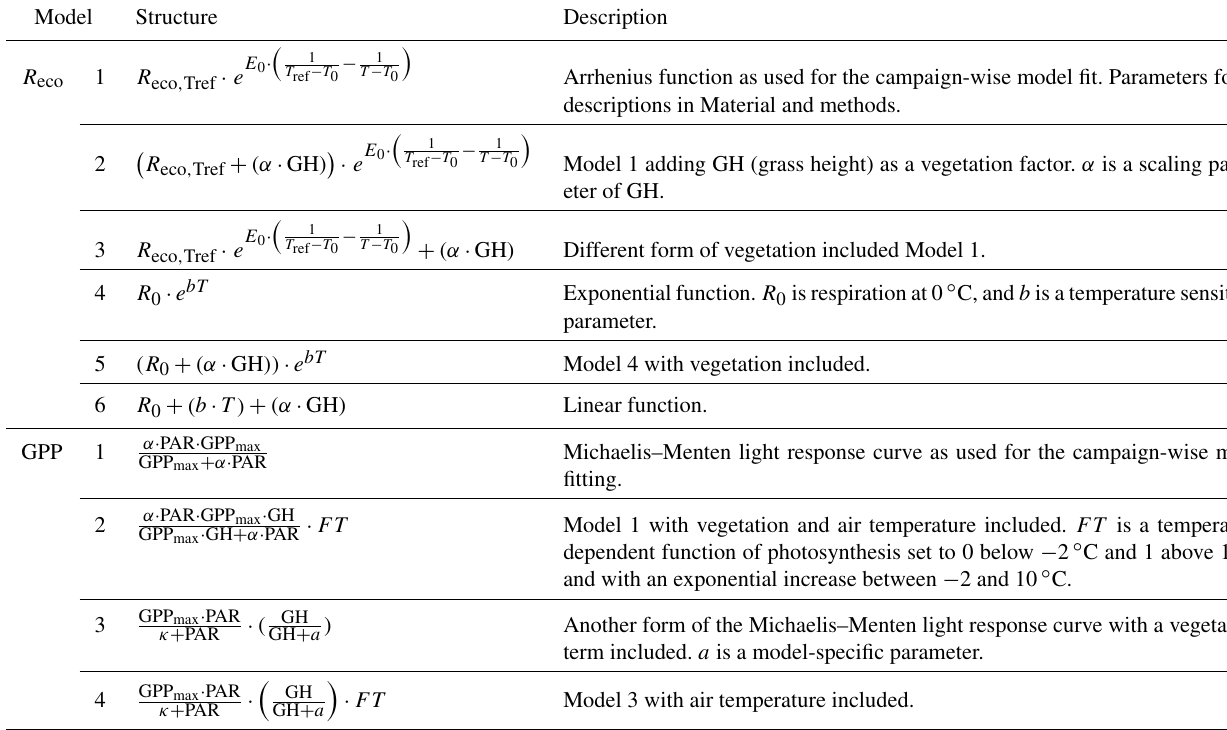
Table A1. Model selected for annual-model gap-filling approach of yearly budgets (adopted from Karki et al. 2019), as a measure of extrapolation uncertainties. Model Structure